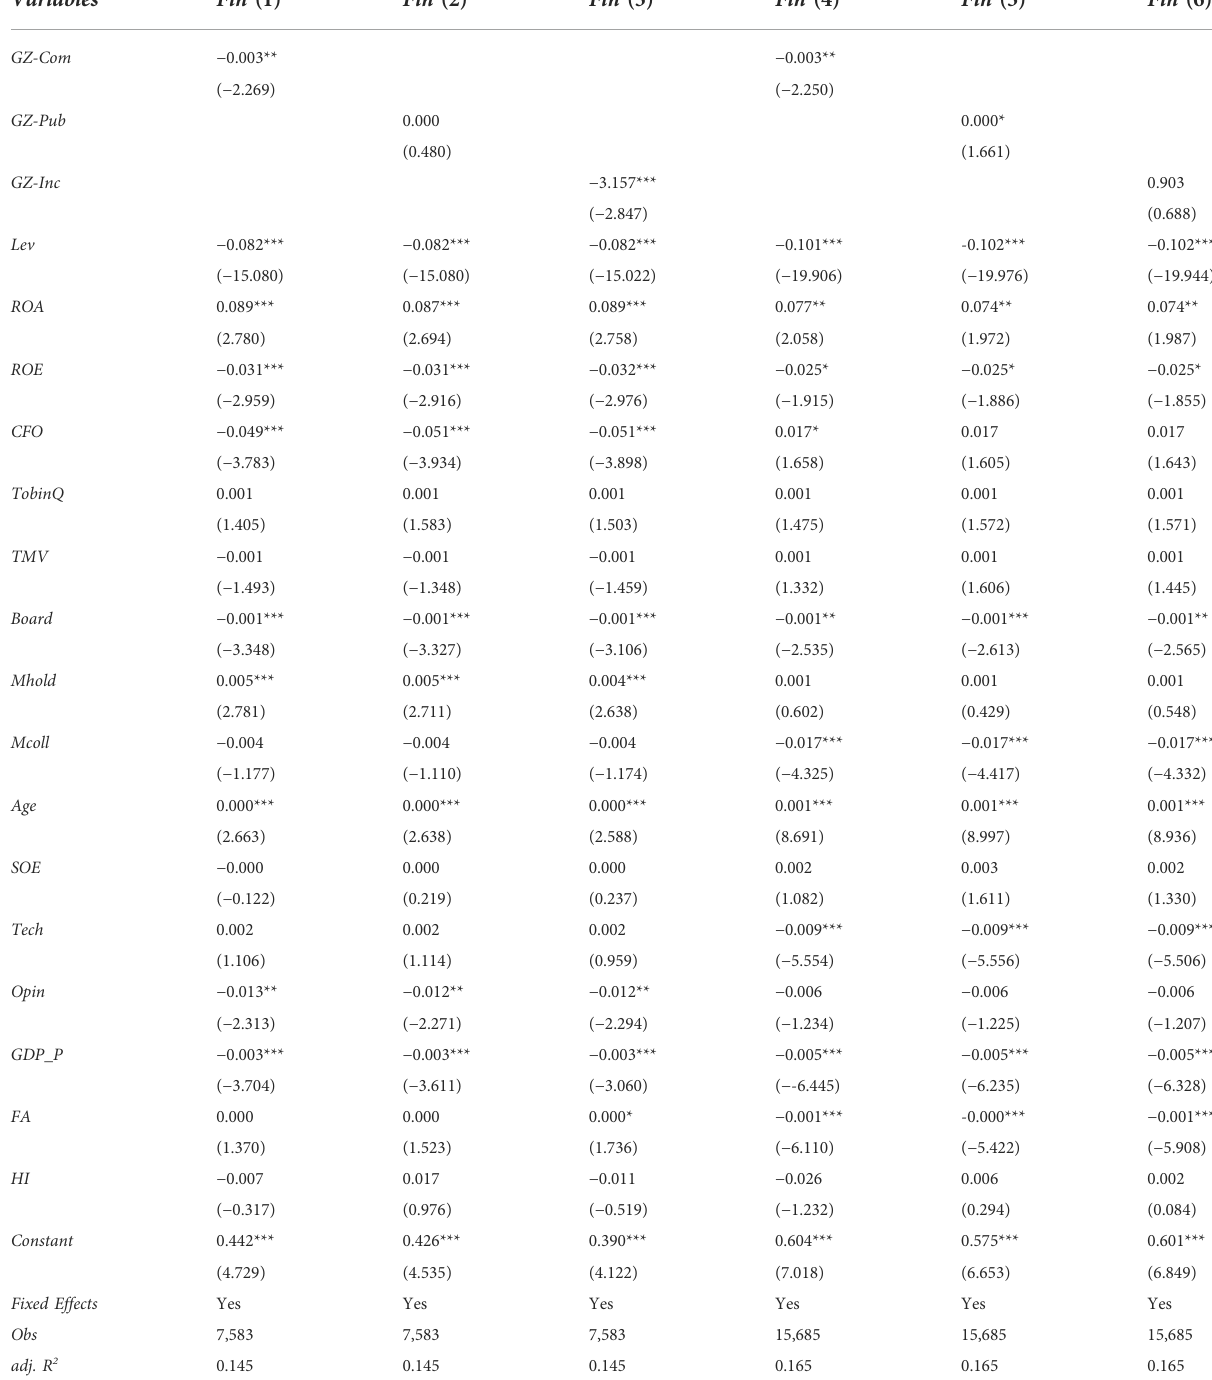
TABLE 9 Grouping test results of heavy and non-heavy pollution